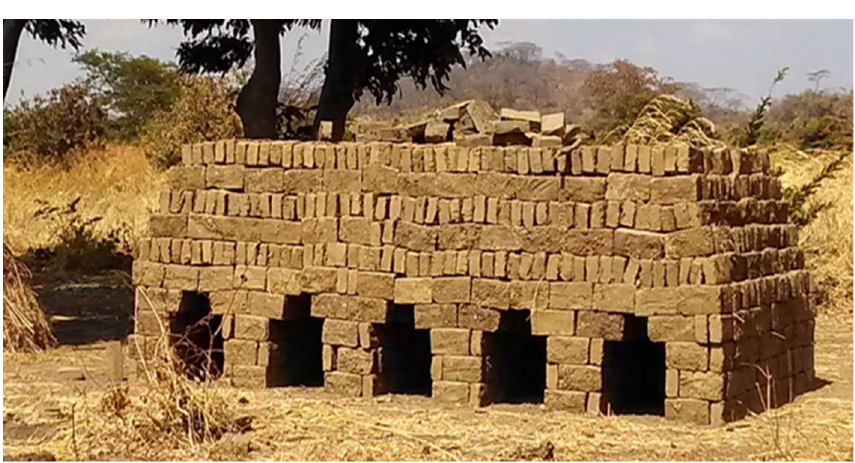
Figure 7. Building materials used in Mwazisi ( n = 399).